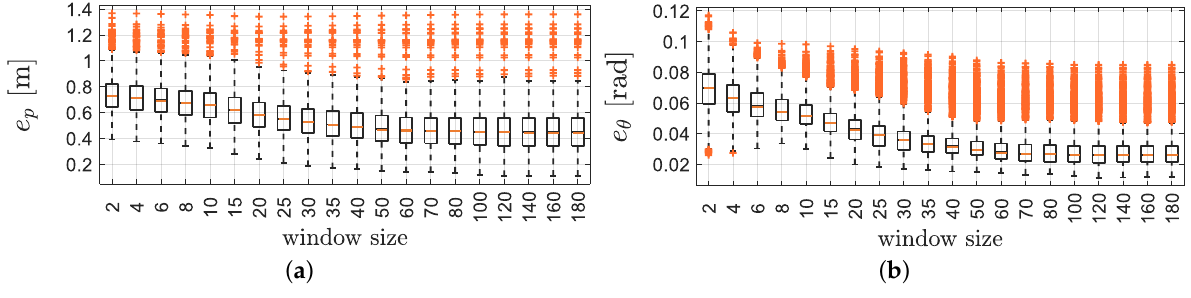
Figure 5. The RMSE for position ( a ) and orientation ( b ) of the SEKF with different window